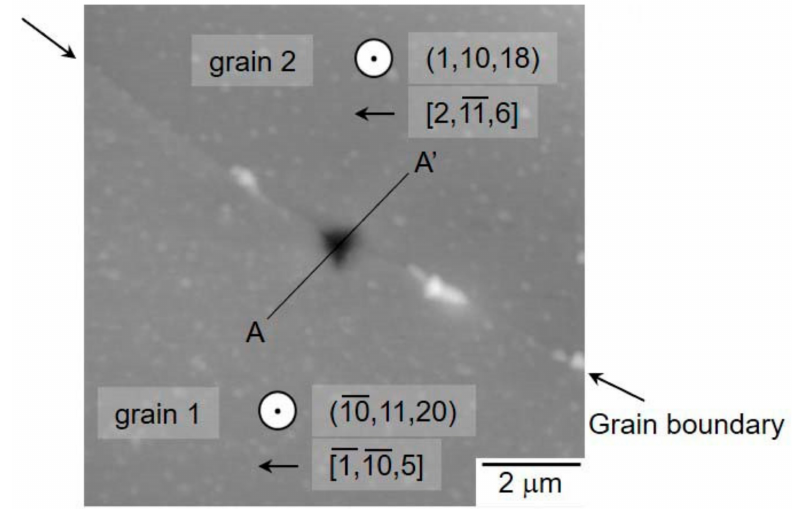
Figure 13. SPM image representing the triangle indent mark on the grain boundary with a high positioning accuracy [135].